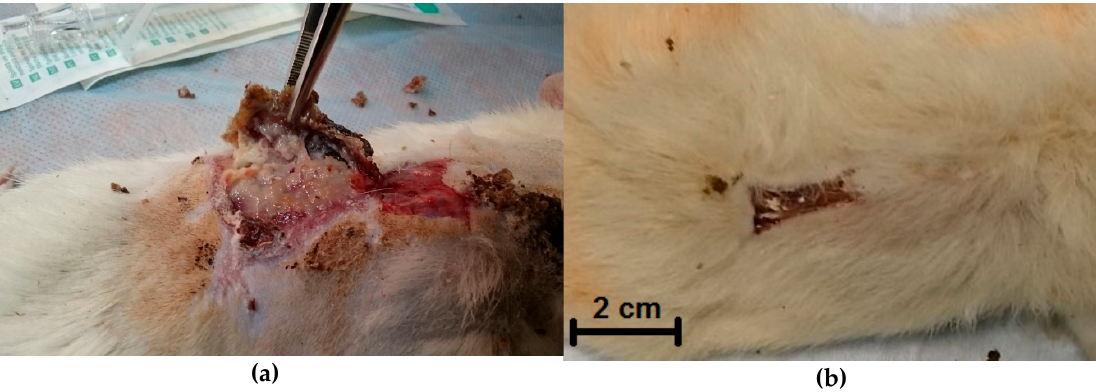
Figure 4. Visual appearance of the wound surface of an animal from the control group ( a ) and of an animal after applying the composite wound dressing ( b ) on the 28th day.